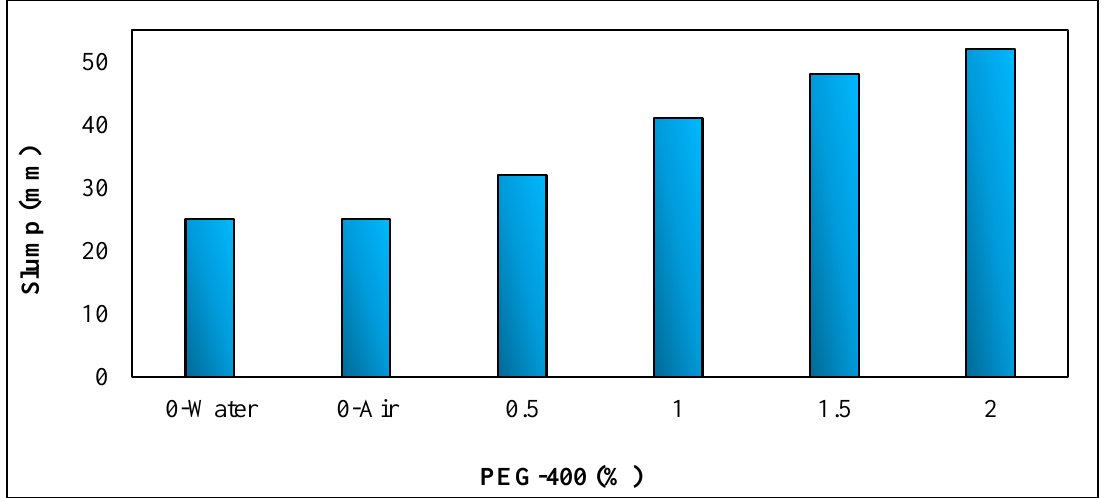
Figure 5. Slump values of concrete containing different PEG percentages.